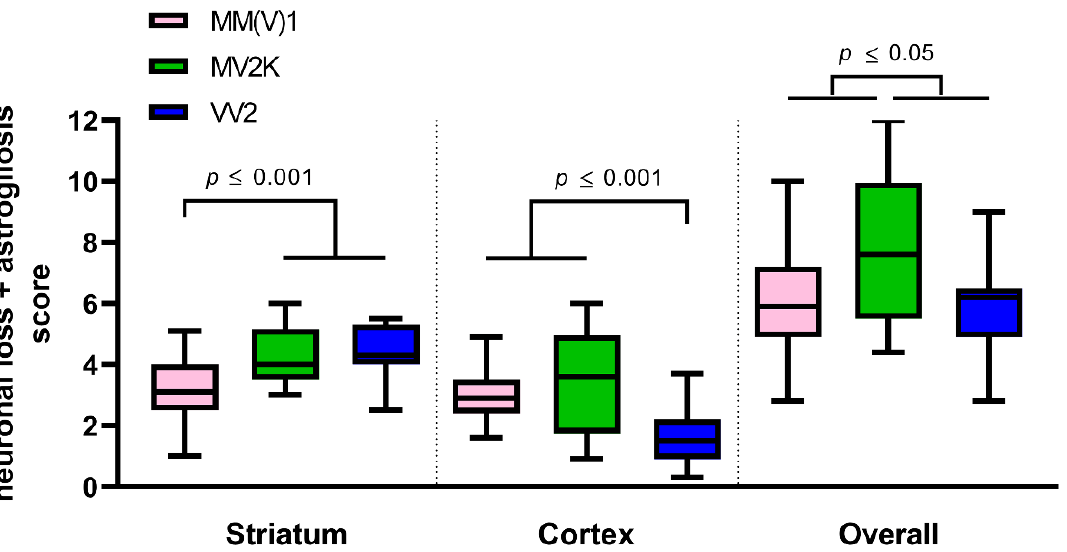
Figure 2. Semiquantitative neuropathological analysis of neuronal loss and astrogliosis in the striatum and cortex of sCJD subtypes MM(V)1, MV2K and VV2. Comparisons between sCJD subtypes MM(V)1, MV2K and VV2 concerning the score of neuronal loss and astrogliosis in the striatum and cerebral cortex. Kruskal–Wallis test and Dunn’s post hoc test.